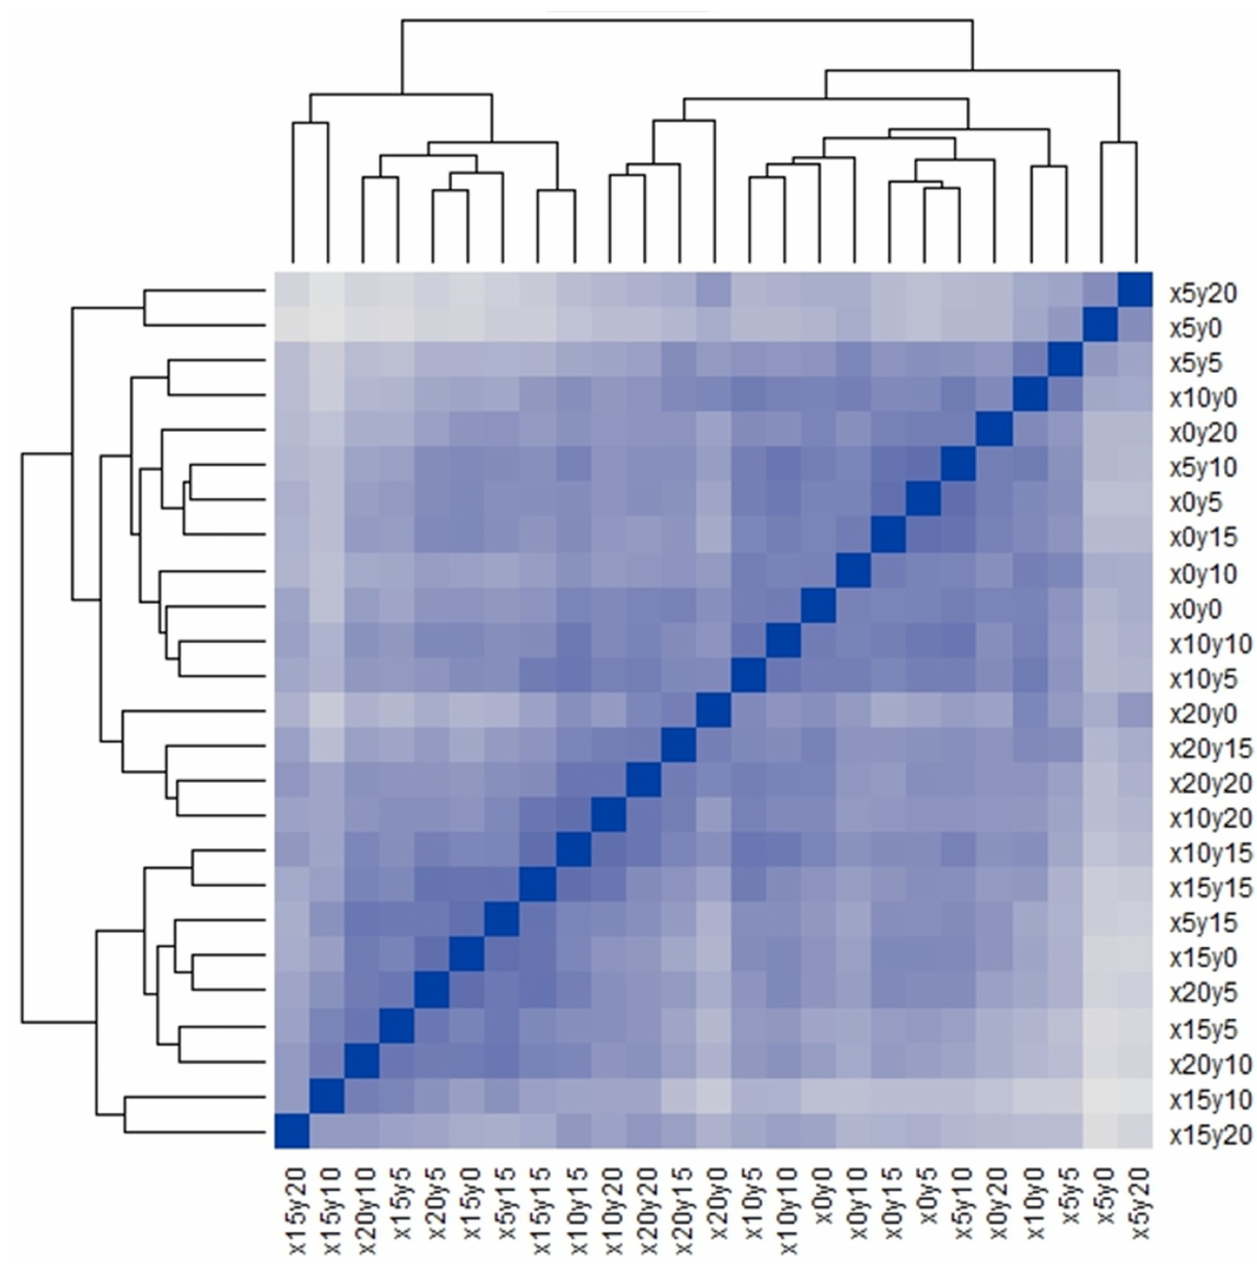
Figure 1. Seriated heat map of 25 quadrats. The blue-scaled color as a meter indicates the value of